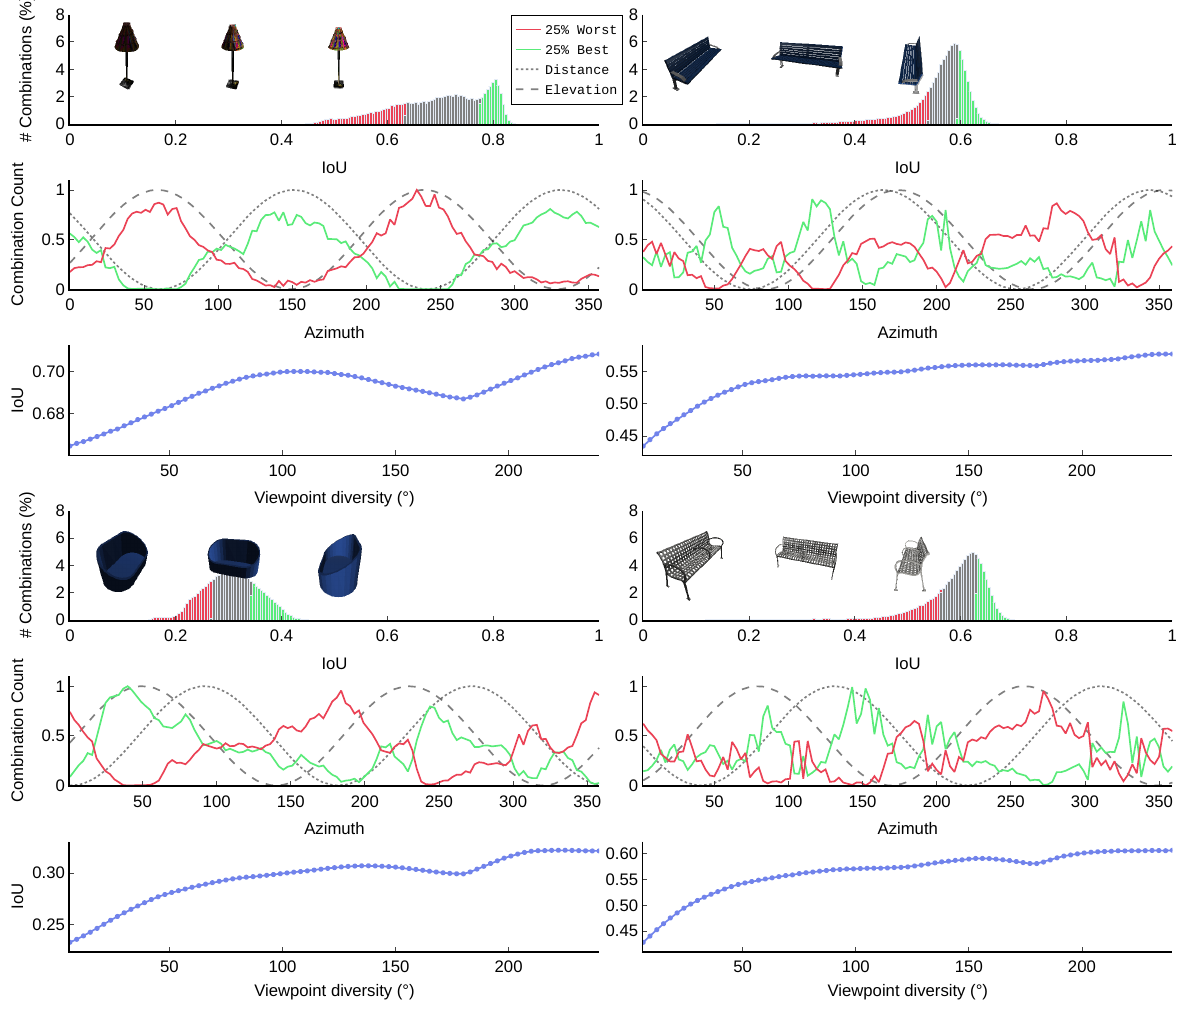
Figure 8. Qualitative insights on how viewpoint selection affects 3D reconstruction quality. For four different objects, all combinations of 3 out of 120 viewpoints were evaluated. For each object, the upper graph shows the histogram of IoU values, with red bars indicating the worst 25% selections and green bars indicating the best 25% selections. The middle graph indicates for each viewpoint (azimuth value) how many of the tested combinations containing that viewpoint belong to the worst or best 25% selections. Dashed lines indicate distance and elevation of each viewpoint. The bottom graph plots the IoU in function of the maximum distance between any two of the three viewpoints. Larger maximum distances indicate more similar viewpoints. The figure is best viewed in